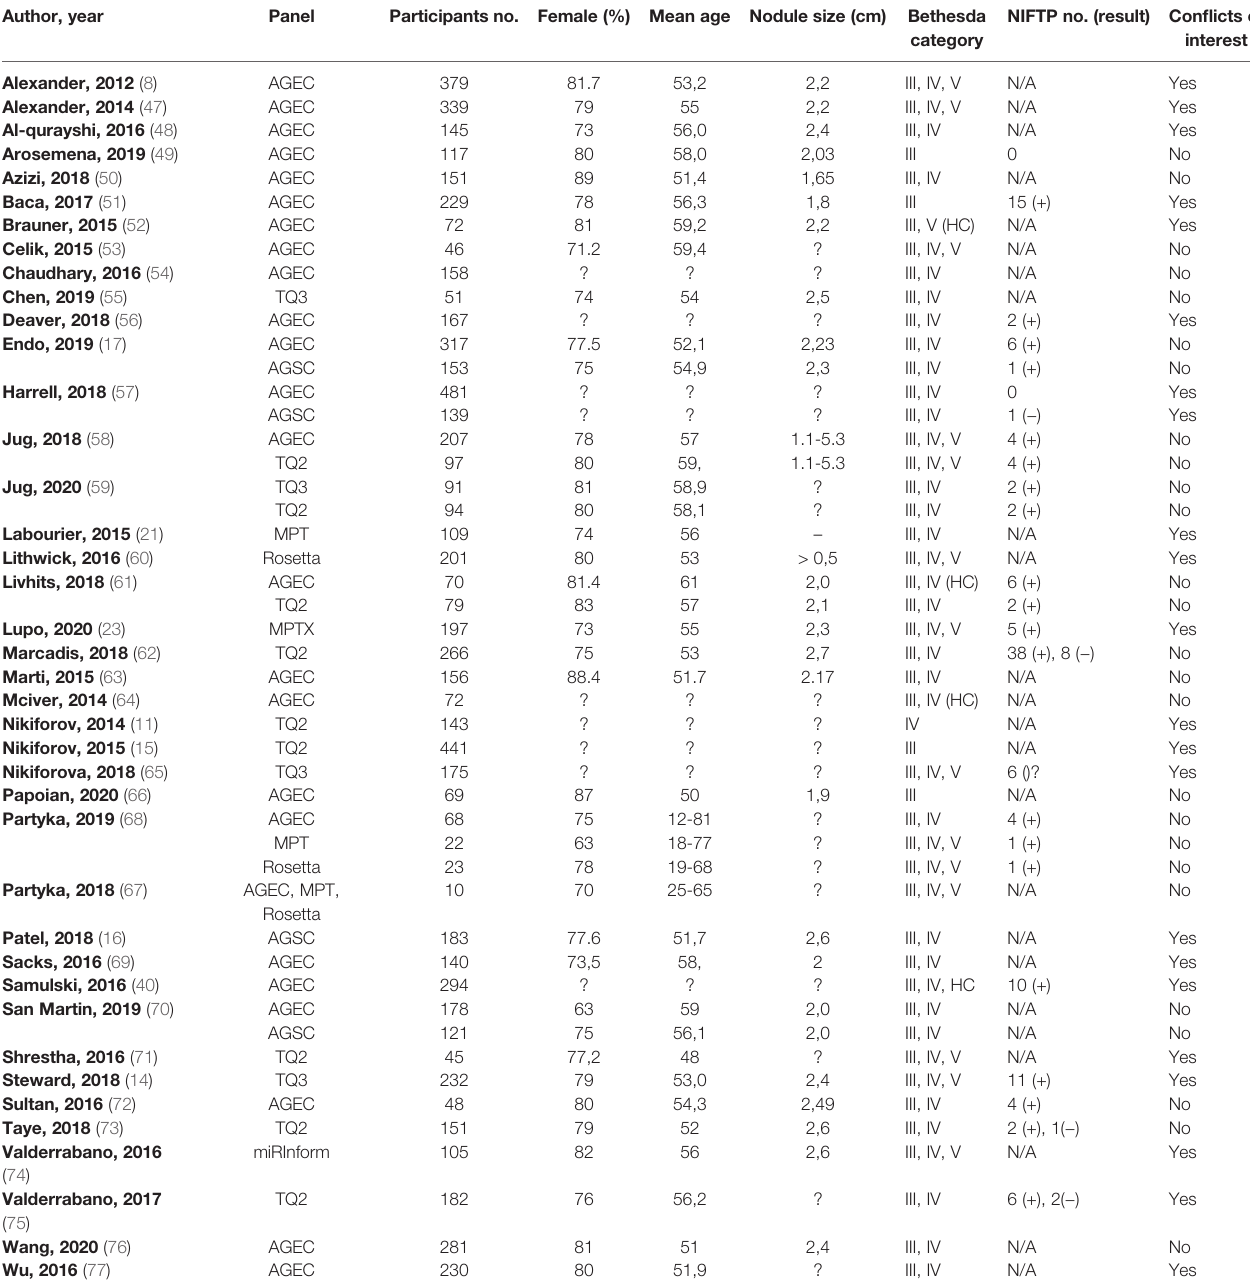
TABLE 1 | Characteristics of the included studies. Author, year